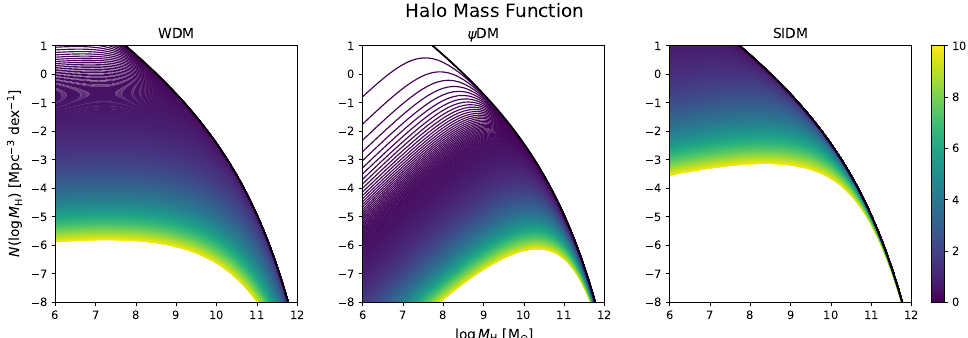
Figure 2. Halo mass function at a reference redshift z ≈ 10 in different DM scenarios: WDM (left panel), ψ DM (middle panel) and SIDM (right panel). The colorbar refers to values of keV/ m X for WDM, 10 − 22 eV/ m X for ψ DM and keV/ T X for SIDM. In all panels, the black line refers to the standard CDM